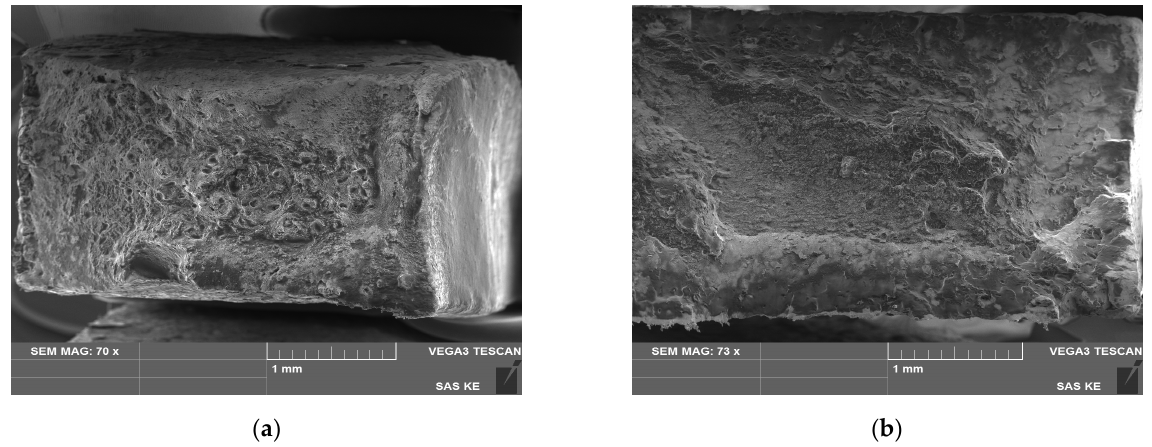
Figure 4. Surface of fracture samples: ( a ) Set 1, ( b ) Set 2 (×70). Scale bar: 1 mm.